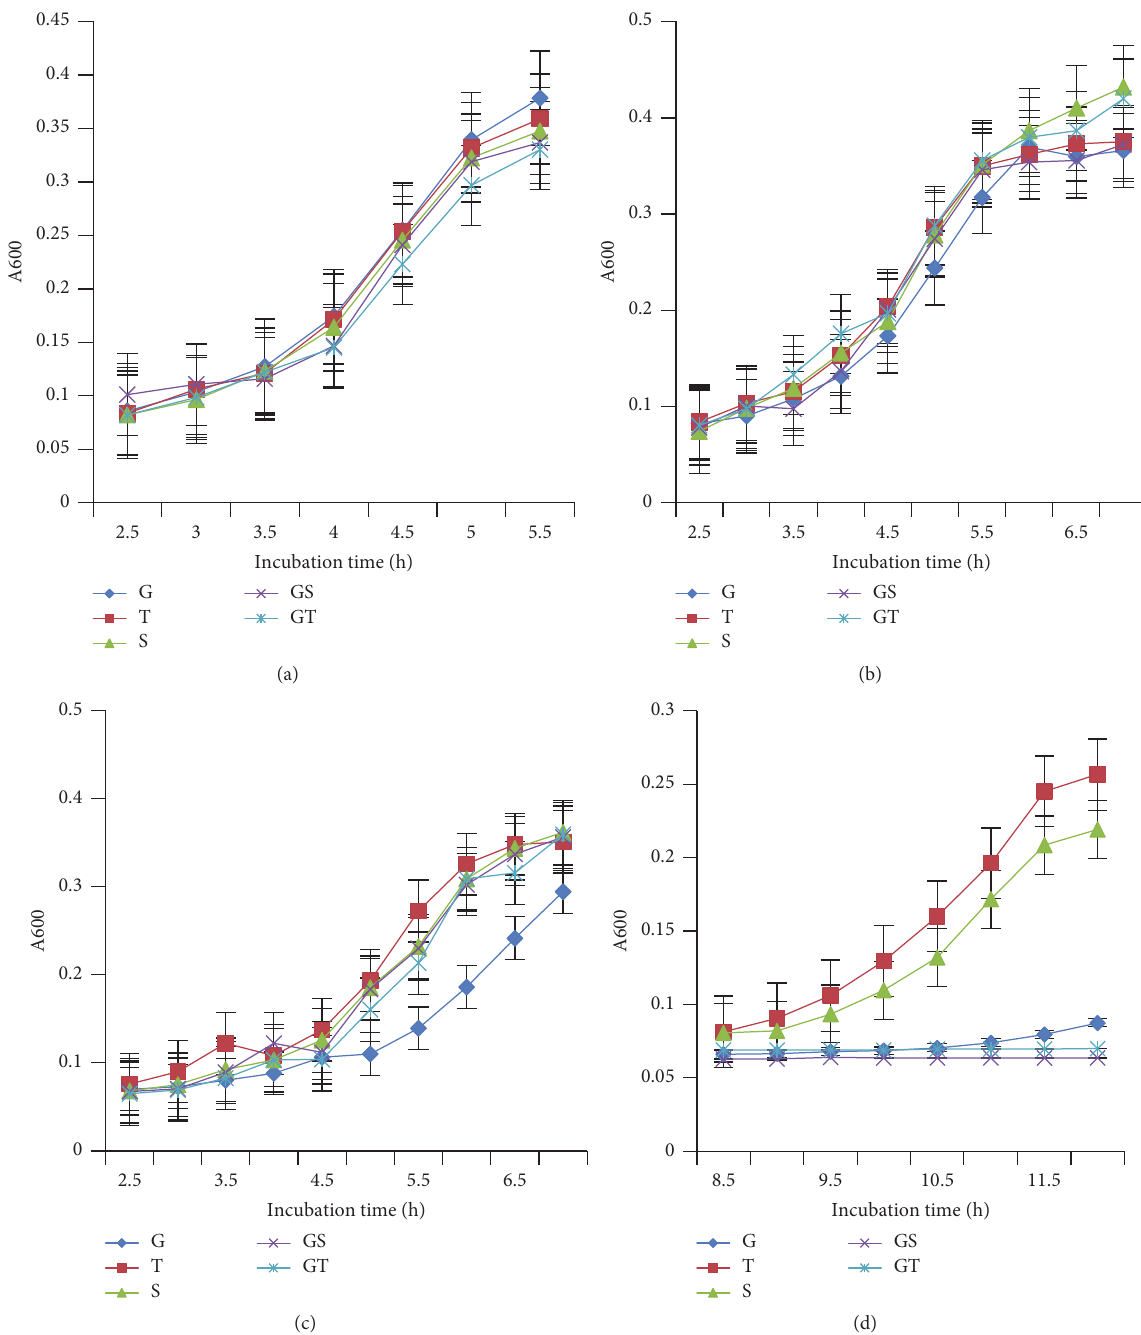
Figure 4: Growth rate of wild type C. perfringens ATCC 13124 with different concentrations of NaCl in the presence and absence of trehalose and sucrose in the minimal medium. Without NaCl (a), 0.5% NaCl (b), 1% NaCl (c), and 2% NaCl (d). G = glucose, T = trehalose, S = sucrose, GS = glucose + sucrose, and GT = glucose +